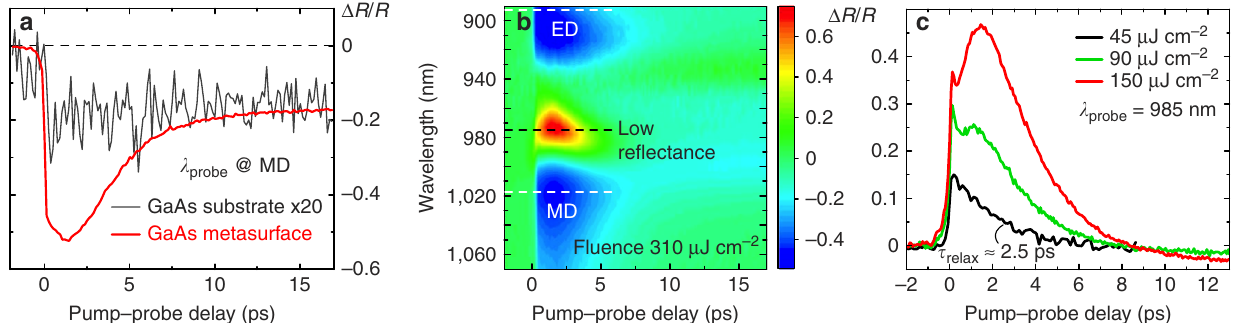
Fig. 3 Transient optical properties of GaAs metasurfaces. a Transient re fl ectance measurement results for the sample ( red curve ) and for the substrate ( black curve ; ordinate values are multiplied by 20 for comparison) at a pump fl uence of 380 μ J cm − 2 . An enhancement factor of about 50 is attained for the modulation depth at the metasurface sample. b Measured differential re fl ectance as a function of probe wavelength and time delay between the pump and probe pulses. White dashed lines denote the spectral positions of the ED and MD modes, while the black one indicates the area of low re fl ectance situated in between the resonances. c Power-dependent transient re fl ectance traces. The low-perturbation regime ( black curve ) reveals exponential decay with a time constant of τ relax ≈ 2.5 ps, whereas higher fl uences ( red and green curves ) provide more complicated traces owing to the blue shift of the MD